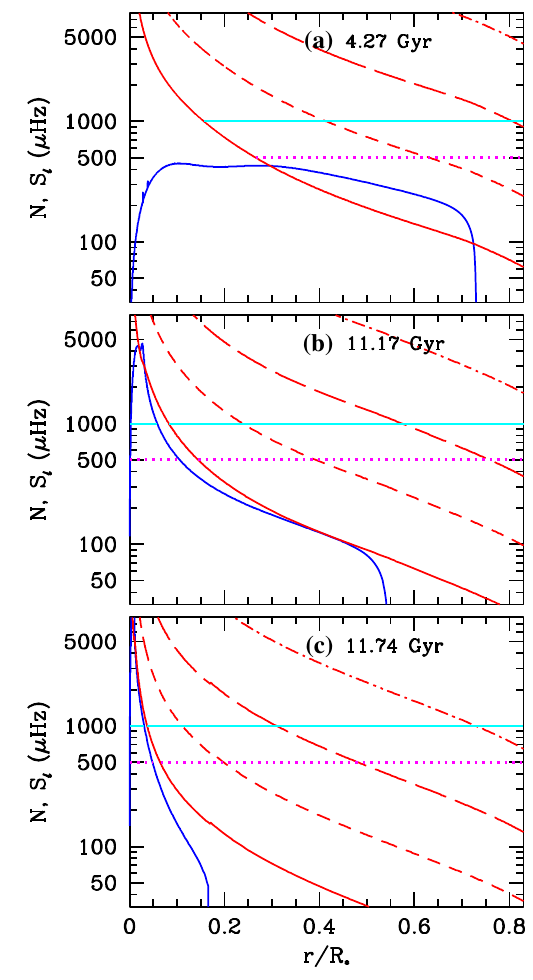
Fig. 38 Propagation diagram for a 1 M (cid:6) stellar model in the main-sequence ( a ), subgiant ( b ) and redgiant ( c ) stages. The blue line is the Brunt–Väisälä frequency, while the red lines show the Lamb frequency for (cid:2) = 1 ( solid line ), (cid:2) = 5 ( small dash ), (cid:2) = 20 ( long dash ) and (cid:2) = 100 ( dot-dashed line ). The horizontal cyan line shows the propagation cavity for an (cid:2) = 1, 1mHz mode and the horizontal dotted magenta line shows the cavity for an (cid:2) = 1, 0.5mHz mode. Note that for the star in a